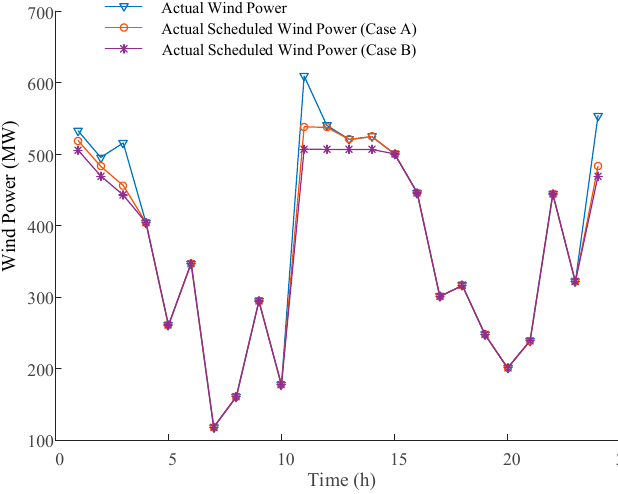
Figure 10. Scheduled power in real-time scheduling stage.